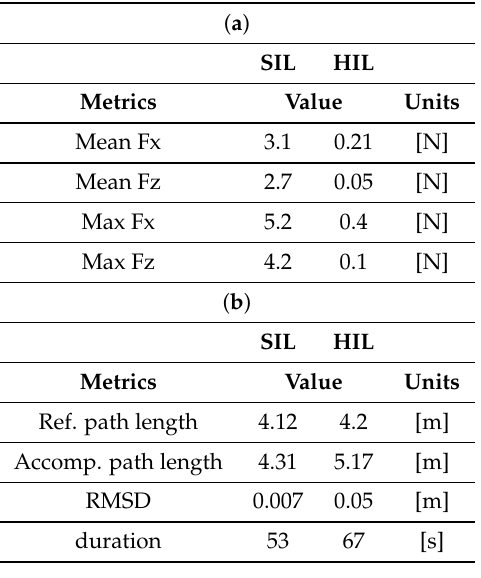
Table 4. Key figures of the path planning experiment with obstacle avoidance performed in SIL and HIL environments. ( a ) Mean and max force reference commands obtained by the FL controller. ( b ) Length of the reference path and the accomplished path, RMSD, and the duration of the